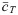
Structure of the nullclines at different values of c¯T indicated in the title of each panel.The black line indicates the first nullcline c˙d=0, while the orange lines corresponds to c˙sr=0. Dots indicate the fixed points. Filled dot: stable fixed point and unfilled dot: unstable fixed point.